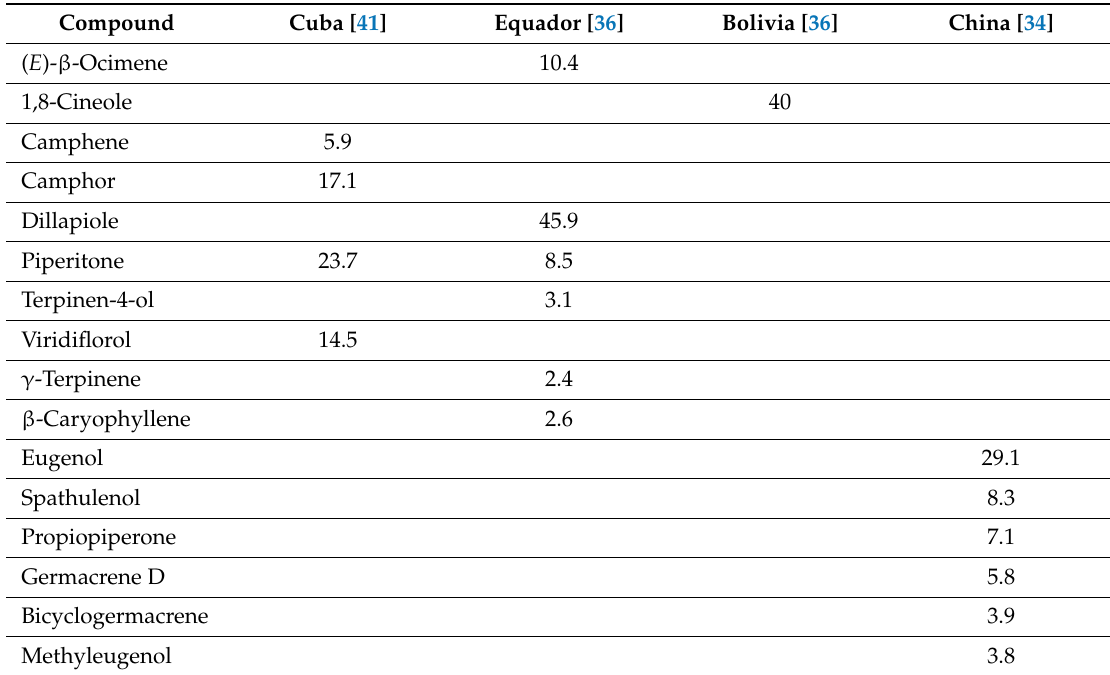
Table 4. Chemical compositions (%) of Piper aduncum essential oils from aerial parts, other countries. Compound